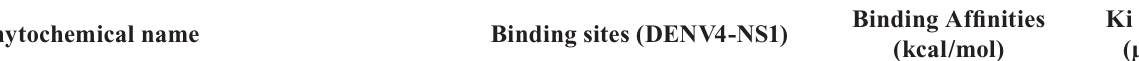
TABLE III - Docking of phytochemicals from Tanacetum parthenium and Silybum marianum with DENV4-NS1